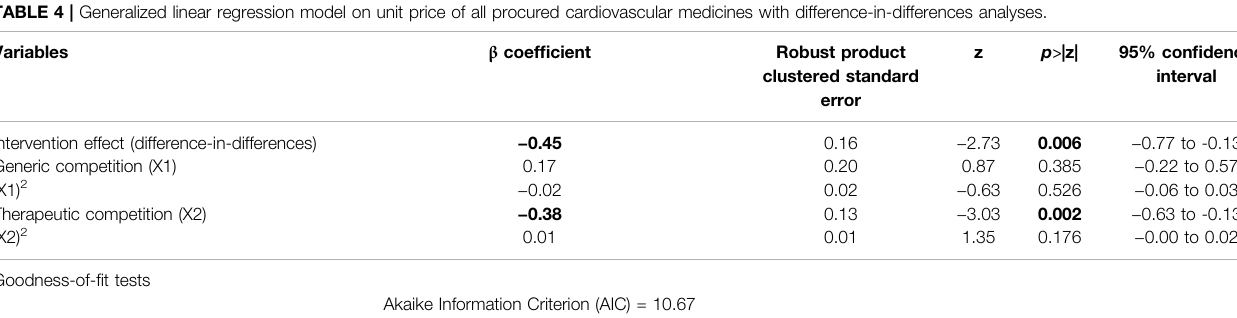
Intervention effect